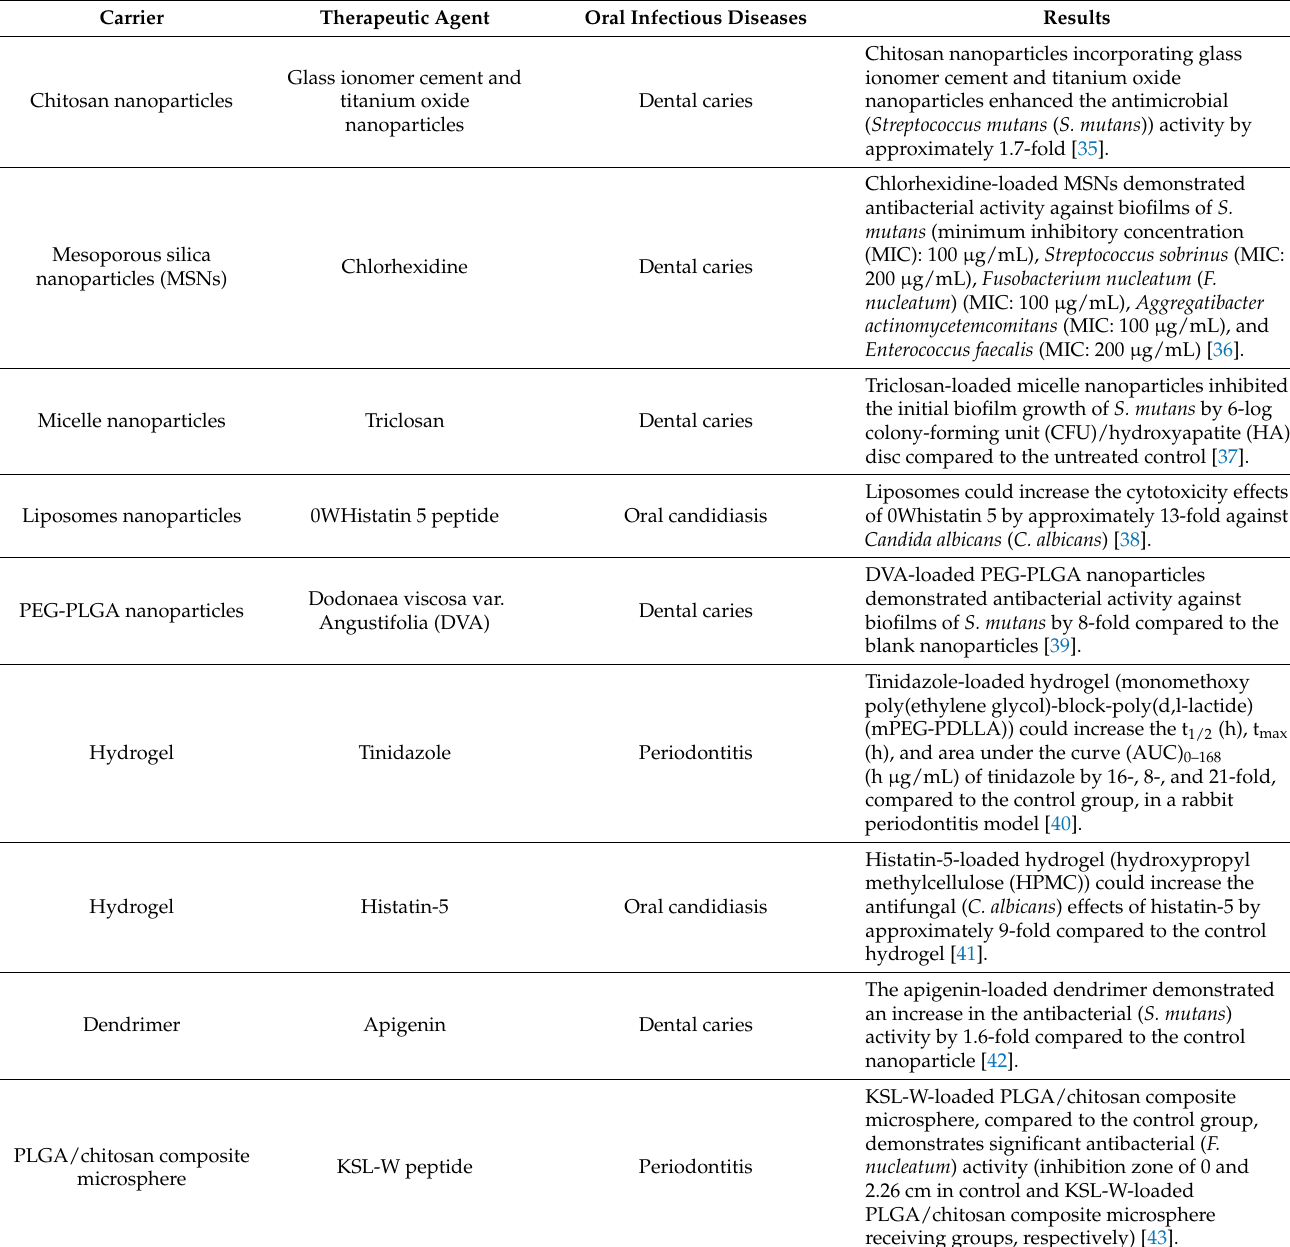
Table 1. Various drug carriers used for the treatment of oral infectious